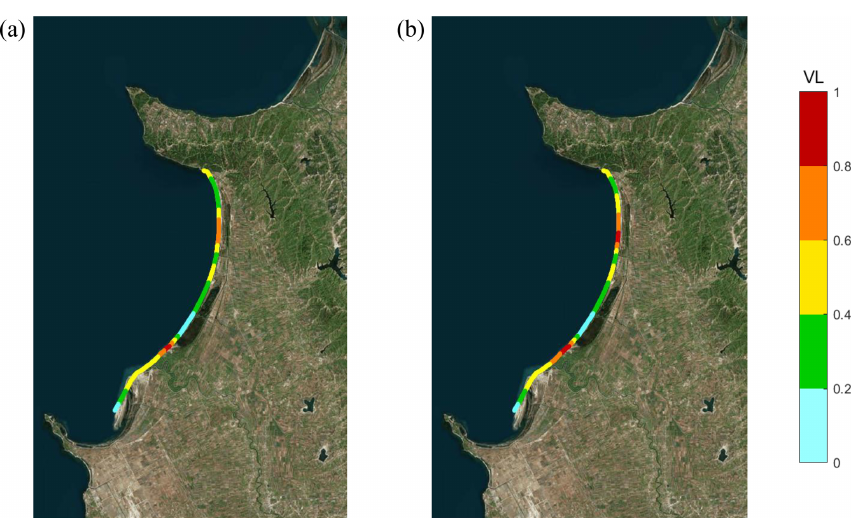
Figure 5. Run-up vulnerability levels for the Bay of Lalzit from the regional analysis, using deep water data: (a) 50-year return period; (b) 500-year return